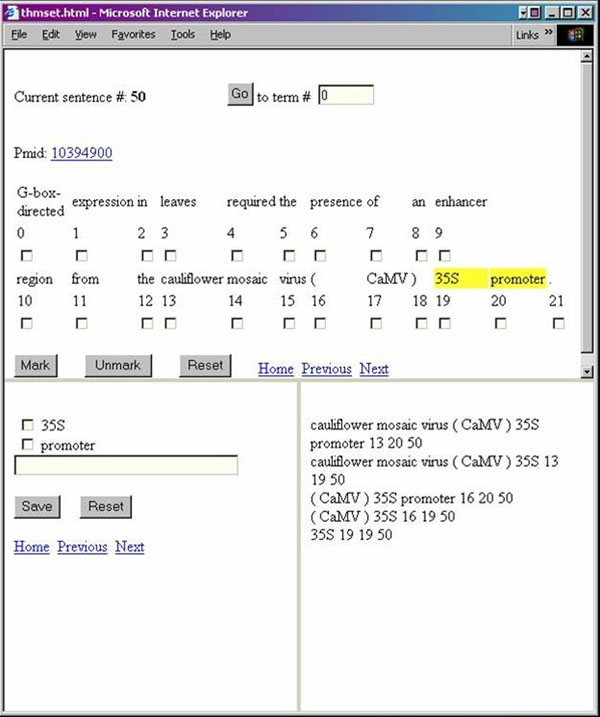
GENETAG Annotation Method. The annotator selects the boxes under each word in a gene/protein name and presses the "Mark" button. The resulting name is highlighted in yellow, and the marked fragments are shown in the bottom left frame. The annotator selects allowable alternatives from this list and presses "Save". Alternatives beyond the scope of the original highlighted name are input manually (along with their indices) into the text entry box. The lower right frame shows all the alternatives to the original name, along with their indices and the sentence number. A link to the abstract is provided for contextual clues.